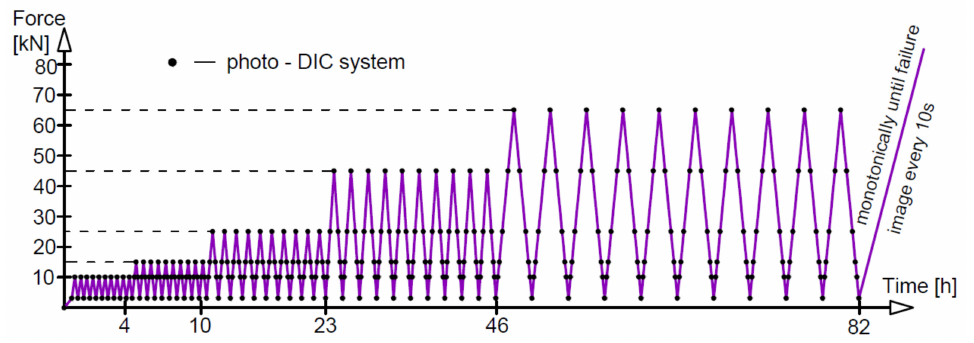
Figure 19. Digital imaging scheme for beams A2O.